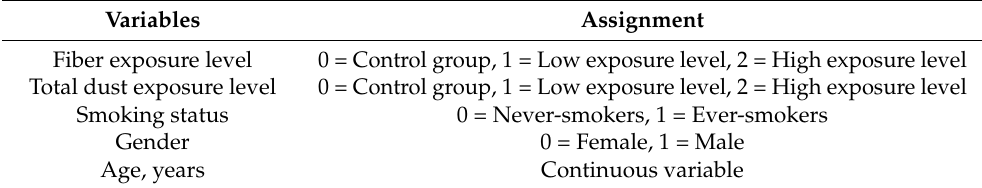
Table A2. Variable assignment of independent variables of multiple linear regression